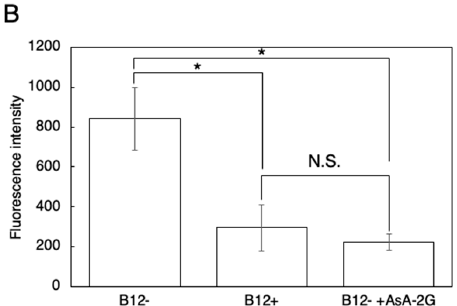
Figure 6. ROS levels in B 12 − , B 12+ , and B 12 − +AsA-2G N2 worms. A. Fluorescence images of young adult N2 B 12+ or B 12 − worms. Reactive oxygen species (ROS) accumulation in the worms was assessed via assay of the ROS indicator 2 ′ ,7 ′ -dichlorodihydrofluorescein diacetate. B. Fluorescence intensity. All values represent the mean ± SD of eight worms per treatment condition (n = 8). Asterisks indicate significant differences ( p < 0.05). N.S., not significant.